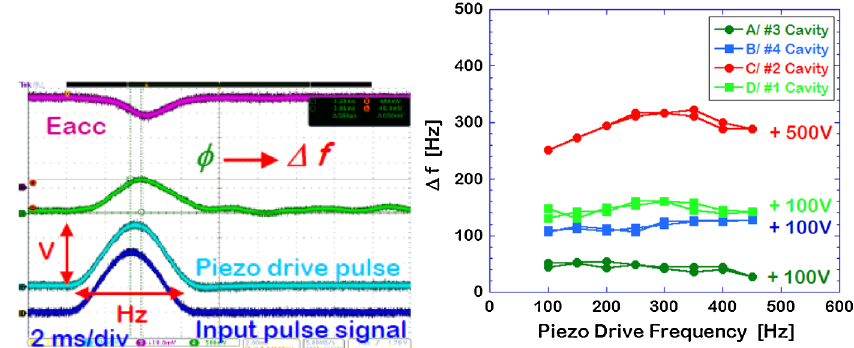
cavity.FIG. 13. (Color) Pulse response signals driven by piezo tuner with single pulse (left) and frequency change ( (cid:3)f ) as a function of drive frequency with piezo tuner